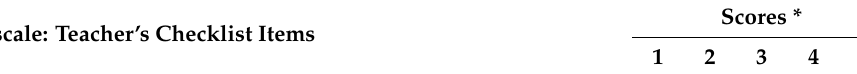
Table 6. An example of MPC subscale: teacher